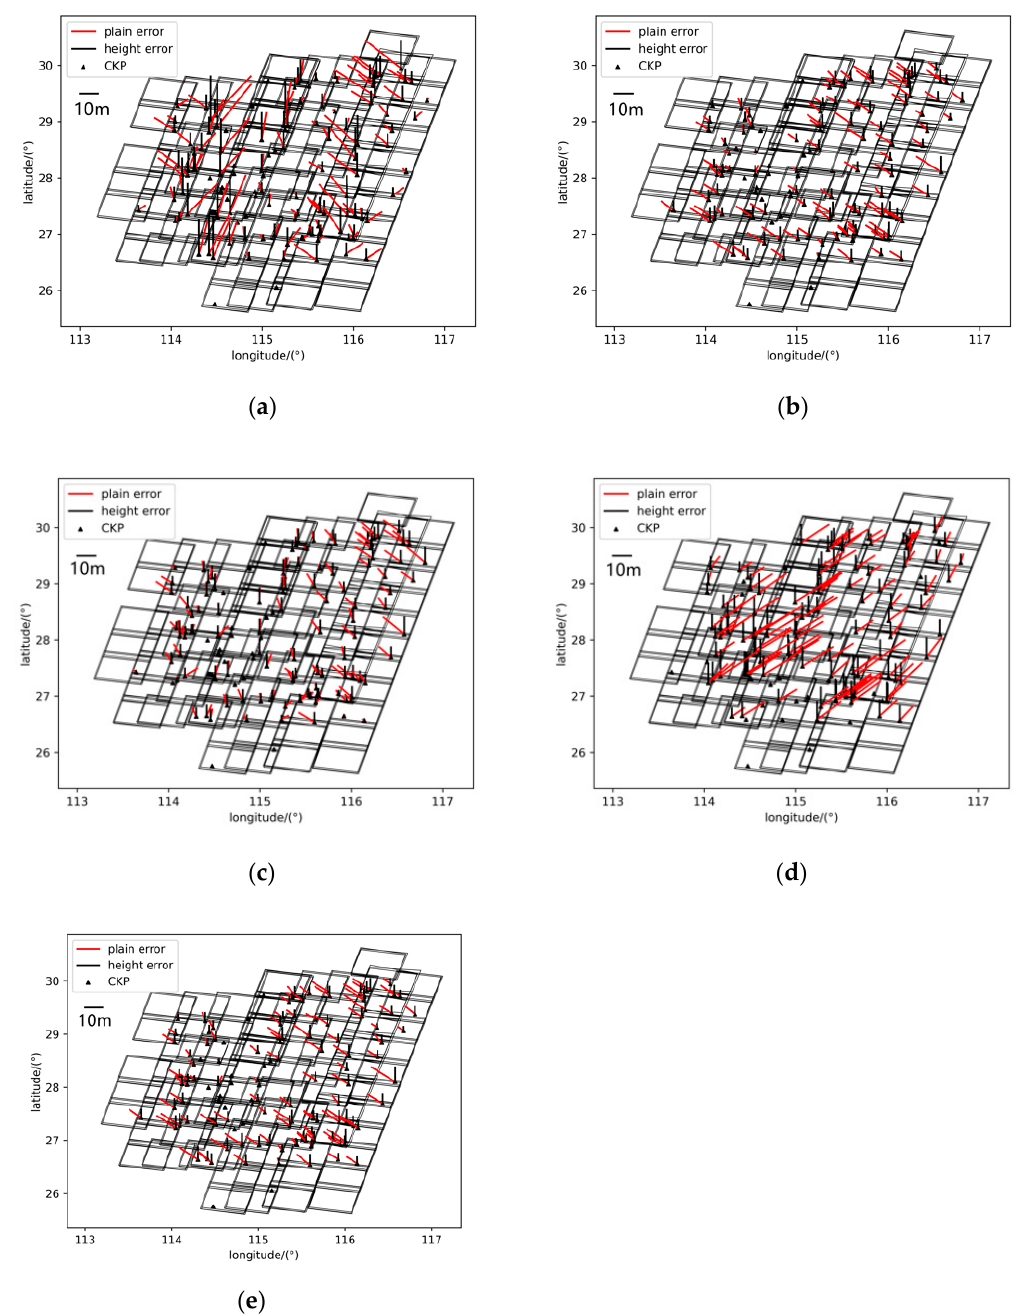
Figure 10. ZY-3 block adjustment each plan residuals distribution. ( a ) plan a, ( b ) plan b, ( c ) plan c, ( d ) plan d and ( e ) plan e.